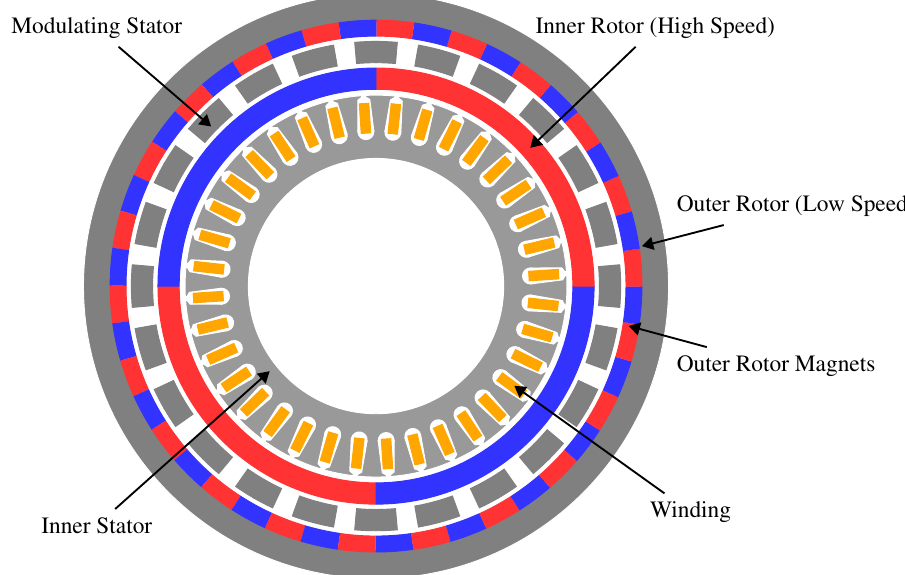
Figure 21. Topology of a magnetically gear motor